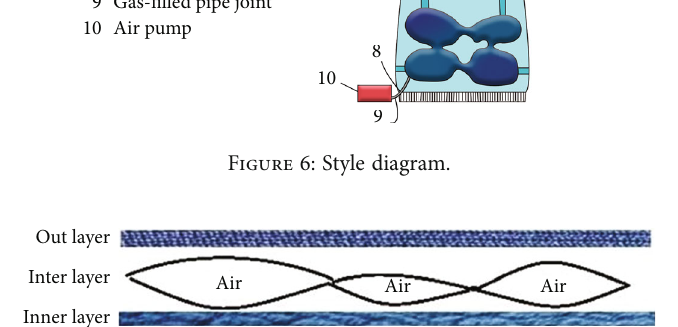
Figure 7: Fabric layer distribution